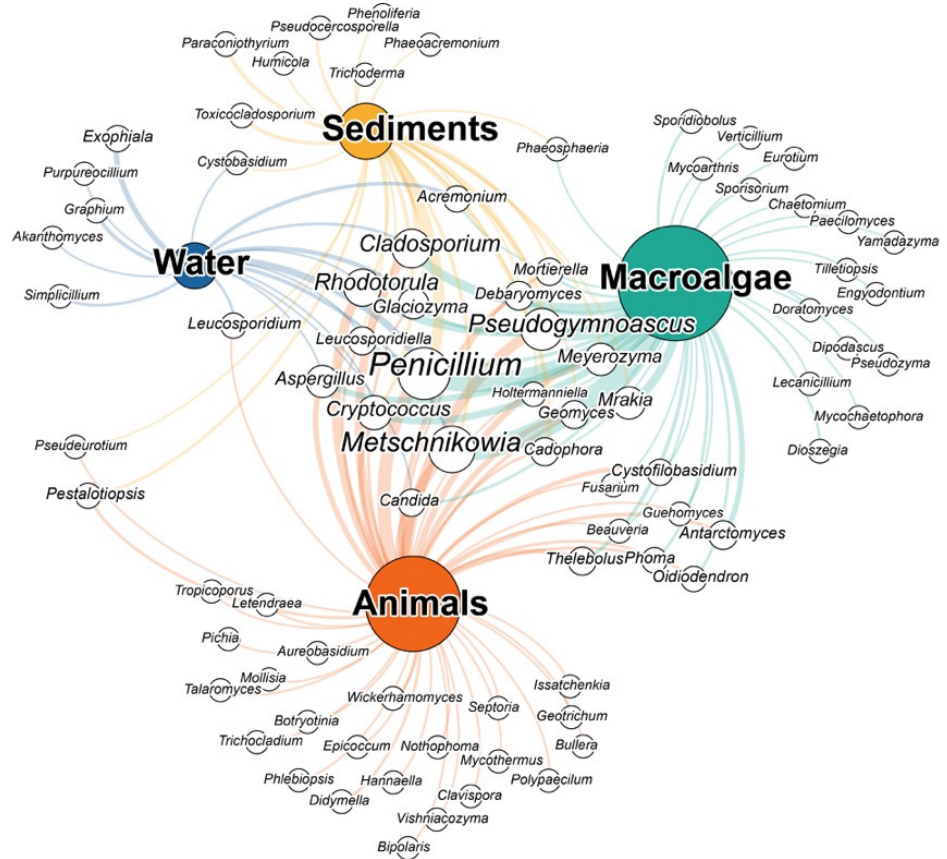
Figure 2. Network diagram displaying the records of Antarctic fungal taxa belonging to different genera identified through culture dependent approaches or metagenomic analyses in the four most commonly marine matrices (water, sediments, animals, macroalgae). The size of the white nodes is proportional to the number of records in the studies in which the genus has been found, while the size of coloured nodes is proportional to the overall number of genera retrieved.